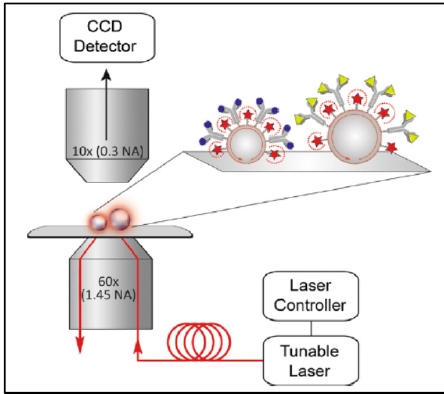
Figure 12. The multiple microsphere resonator system: the objective lens is utilized as the coupling waveguide, while two differently sized microspheres are paired with different receptors. CCD detects the fluorescence behavior of the system. Reprinted with permission from [136].